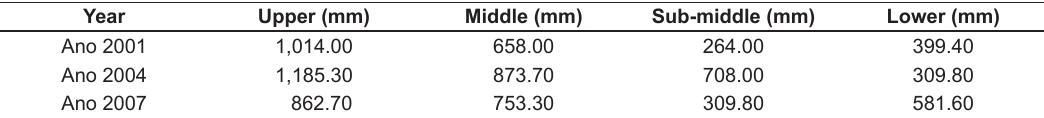
Table 4. Accumulated rainfall (mm) for physiographic sector of the São Francisco (Medeiros et al.,